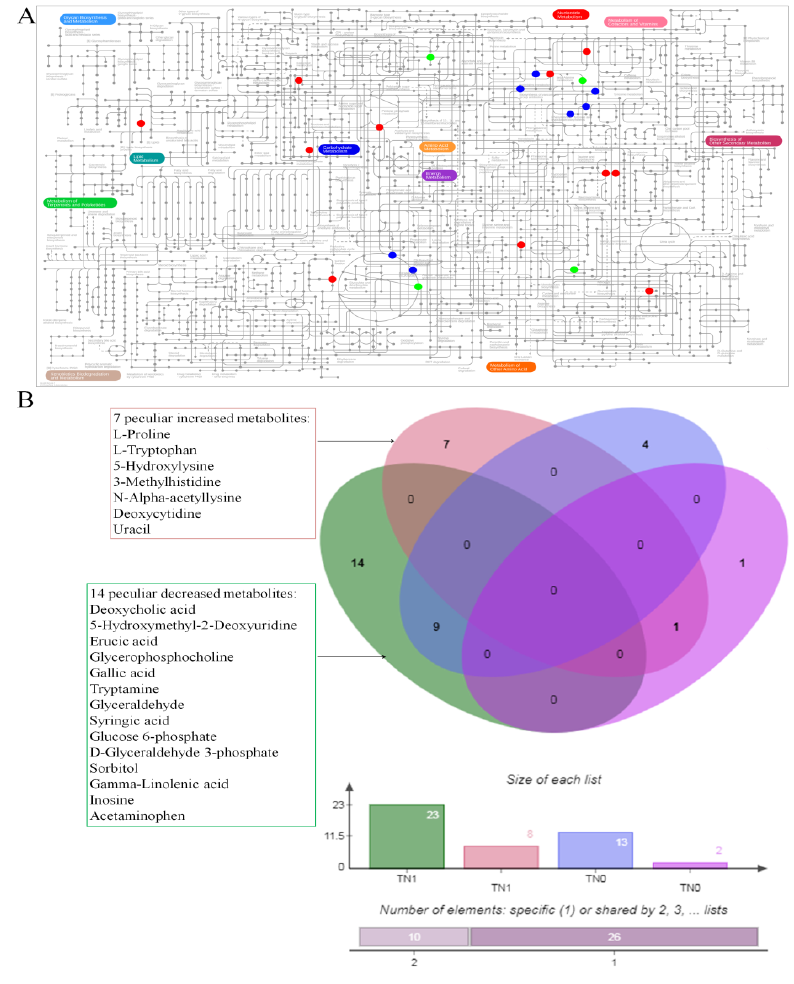
Figure 1. The altered metabolites. ( A ) Visualization of the altered metabolite coverage based on iPath 3.0. The blue points represent the co-owned metabolites in two groups (TN1 and PN1, TN0 and PN0), the red points represent the specific metabolites detected in the lymph node metastasis (TN1 and PN1) group, and the green points represent the specific metabolites detected in the group without lymph node metastasis (TN0 and PN0). The metabolites which are not indicated in the general pathway map are not shown. ( B ) This Venn diagram displays overlaps of differential metabolites between two groups (TN1 and PN1, TN0 and PN0).